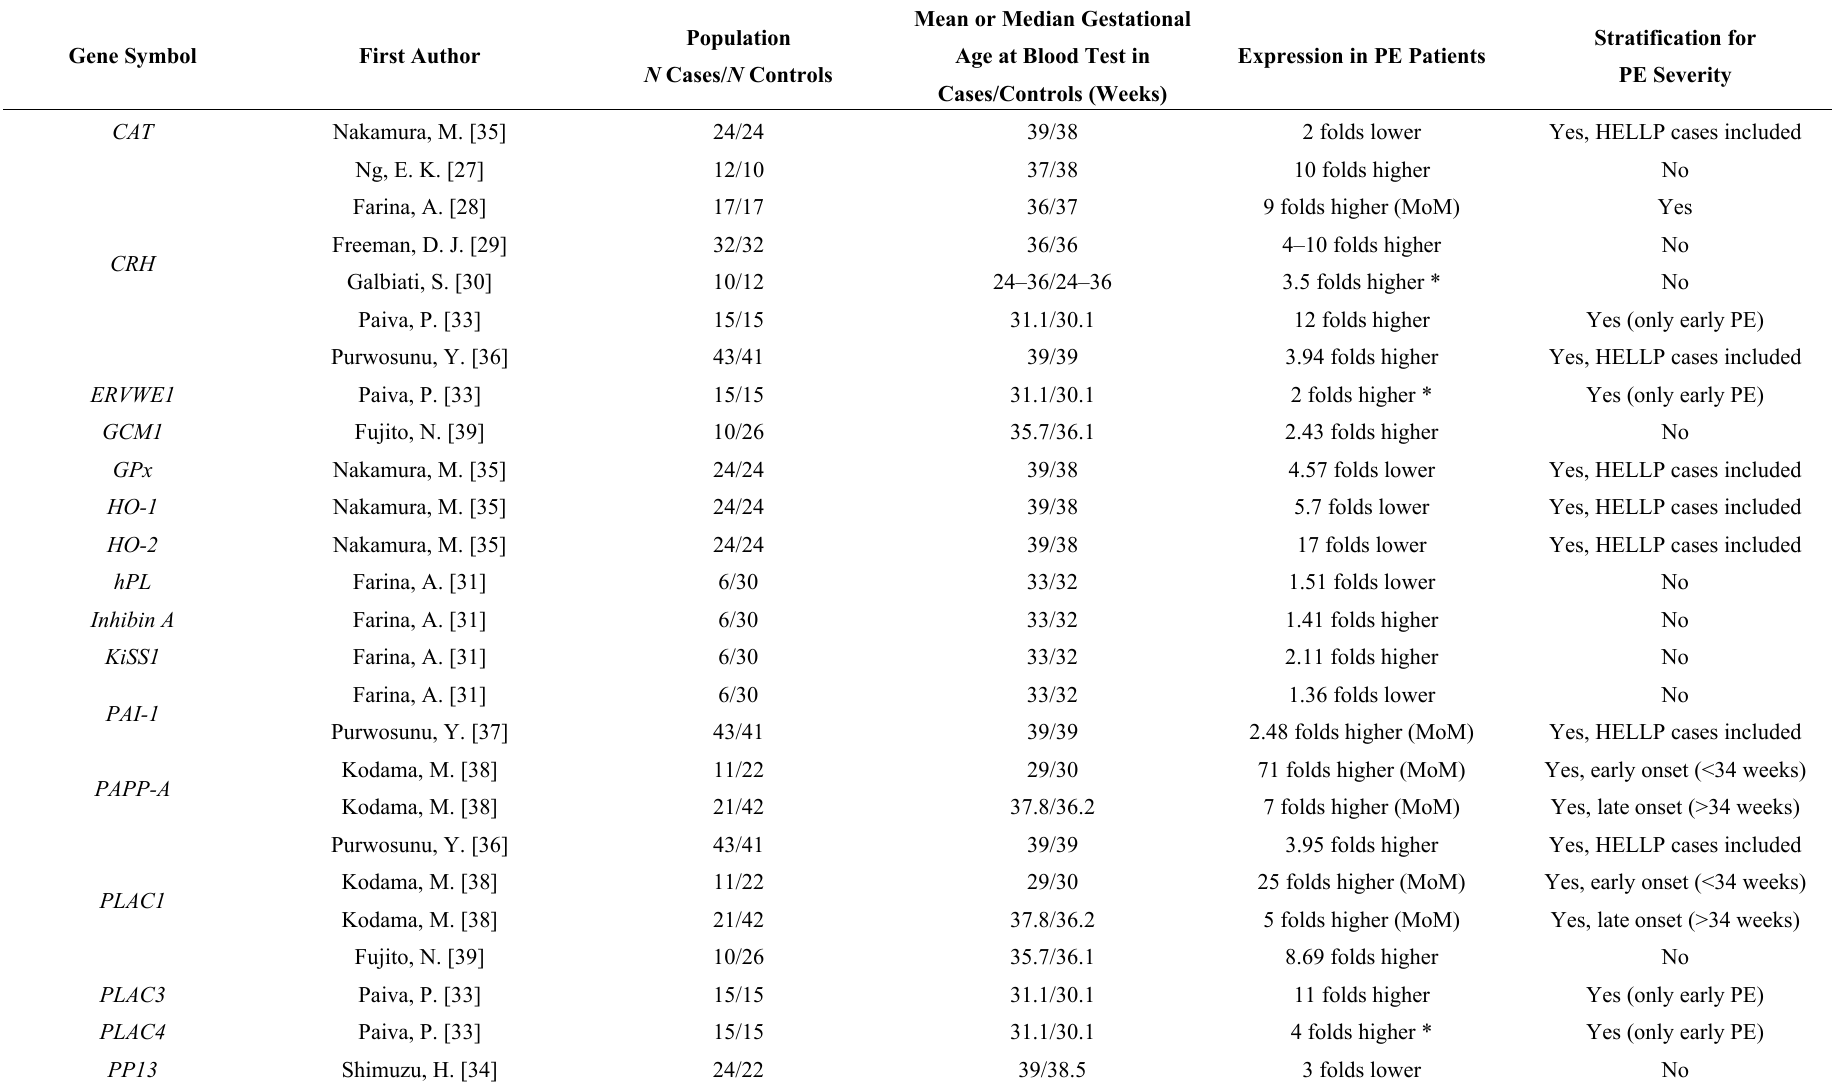
Table 1. mRNA species dosed in maternal plasma or whole blood variably distributed in preclampsia (PE) patients. Gene